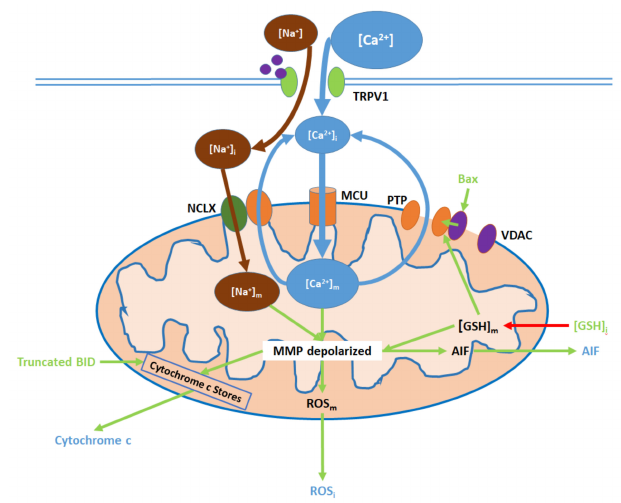
Figure 3. TRPV1 induces mitochondrial dysfunction through Ca 2 + and Na + entry, membrane depolarization, ROS production, and the release of cytochrome c and apoptosis-inducing factor (AIF). Initial Ca 2 + and Na + influx causes the hyperpolarization of the mitochondrial membrane, while consequent Ca 2 + export through the permeability transition pore (PTP) and active Ca 2 + removal via the NCLX depolarize the membrane. As inputs, downregulated [GSH] i and upregulated Bax arise from nuclear activity. Upon their release (driven by membrane depolarization), AIF translocates directly to the nucleus, cytochrome c participates in intracellular caspase 9 activation, and intracellular ROS (ROS i) supports the activation of p38 MAPKs.